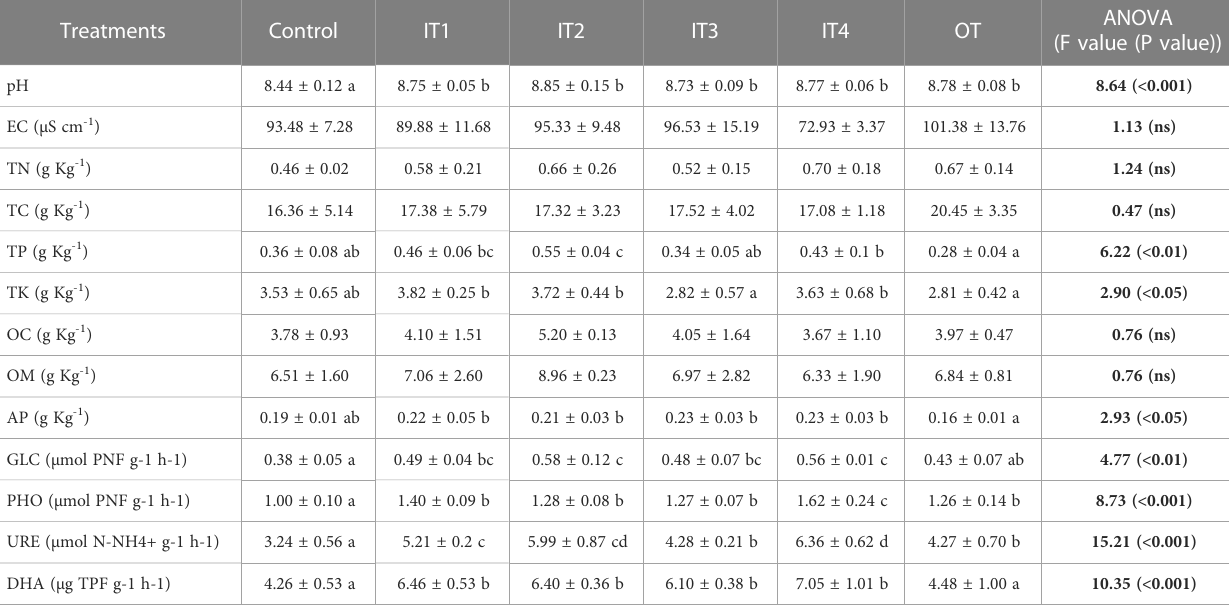
TABLE 1 Chemical, physico-chemical and biological properties of the rhizosphere of purslane plants grown under different fertilization treatments.